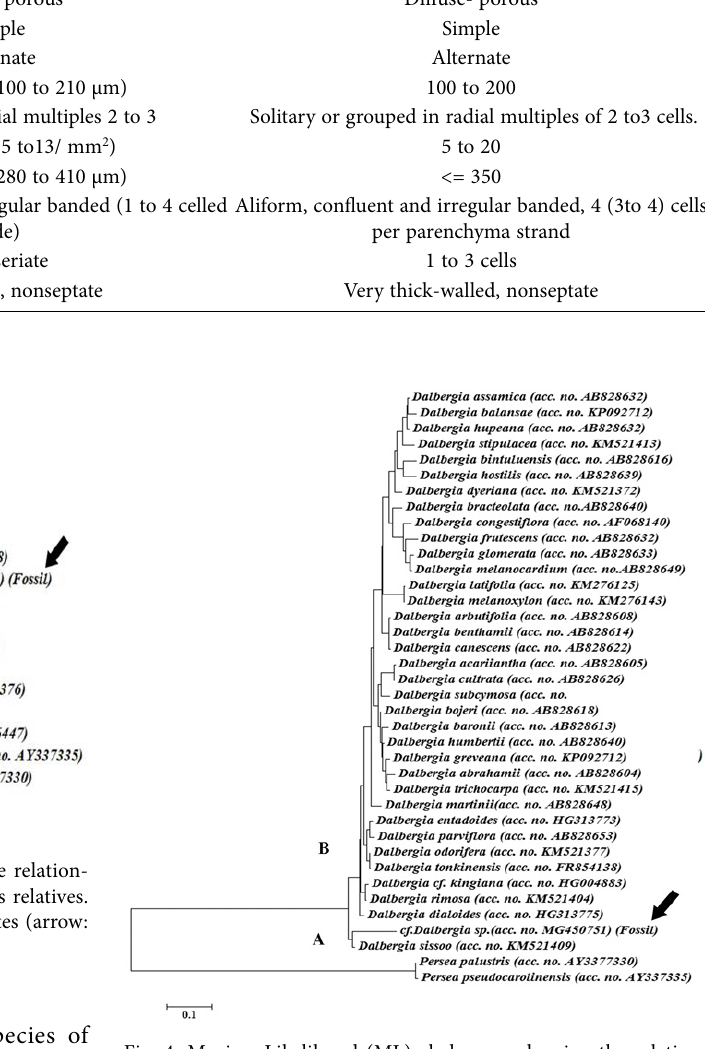
Fig. 4. Maxim- Likelihood (ML) cladogram showing the relation- ships of the ITS gene from cf. Dalbergia sp. in relation to its rela- tives. All analyses were performed with 1000 bootstrap replicates (arrow: fossil specimens, acc. no.: accession